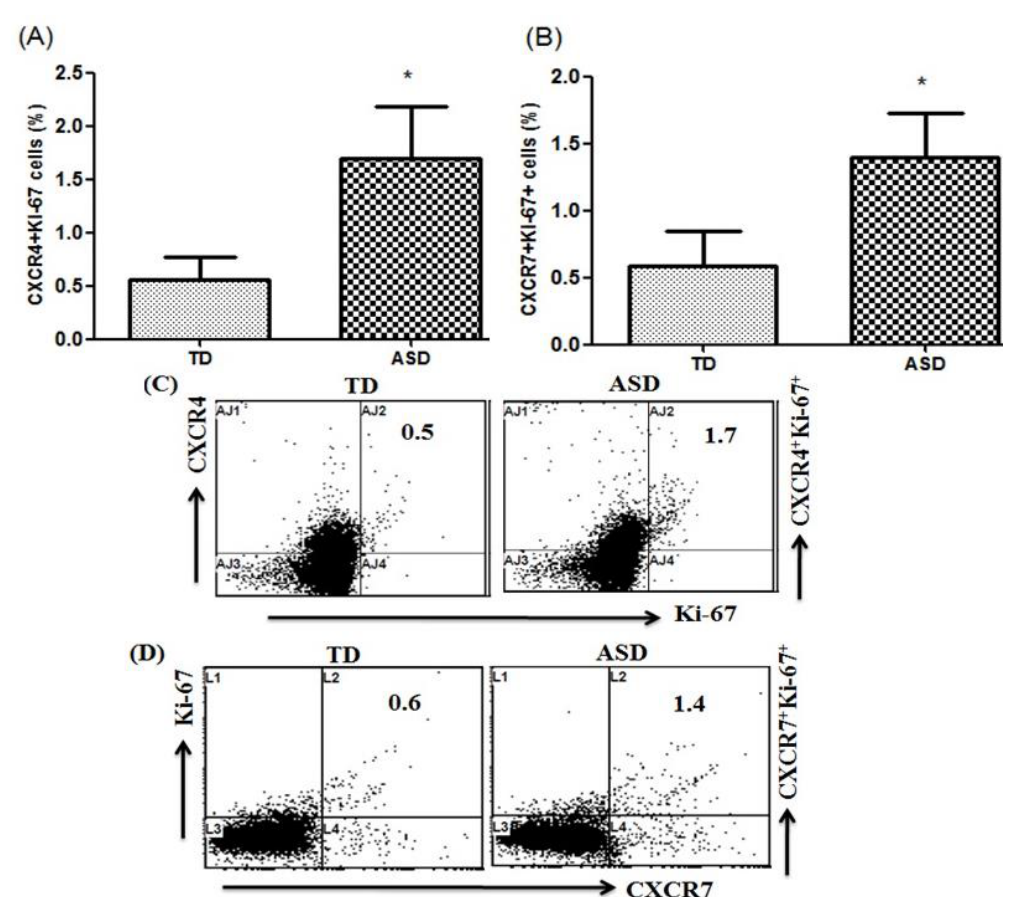
Figure 2. Ki-67 expression in CXCR4+ and CXCR7+ peripheral blood mononuclear cells (PBMCs). ( A , B ) Flow cytometric analysis of Ki-67-producing CXCR4+ and CXCR7+ (chemokine receptors) PBMCs in children with autism spectrum disorder (ASD) and typically developing (TD) controls. ( C , D ) Representative flow cytometry dot plots showing the percentage of Ki-67-producing CXCR4+ and CXCR7+ PBMCs from TD controls and children with ASD. Statistical analysis was carried out by Student’s t -test. Statistical significance was determined as * p <